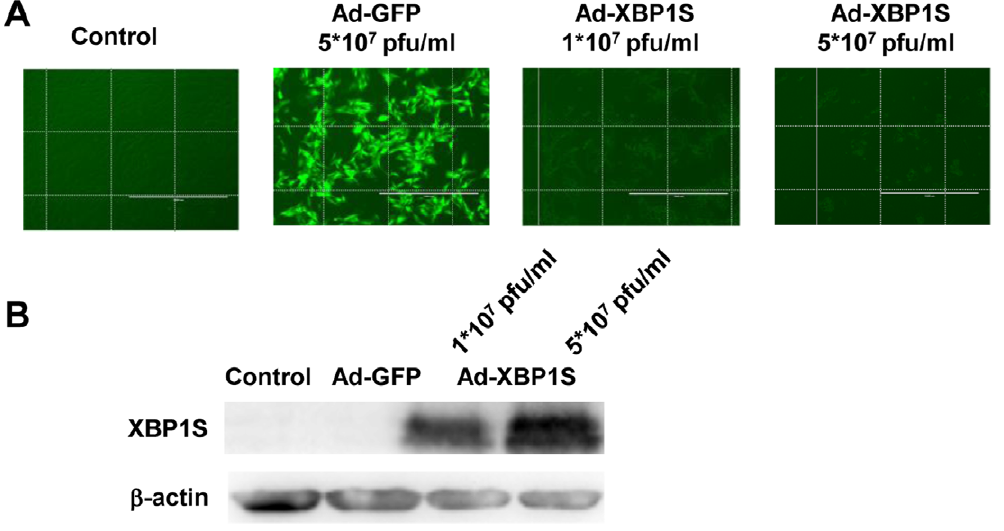
Figure 4. Identification of XBP1S expression after transfection of Ad-GFP or Ad-XBP1S. A: Observation of the cell under fluorescent microscope after transfection of Ad-GFP or Ad-XBP1S for 24 h. B: Western blot analysis on XBP1S protein level after Ad-GFP or Ad-XBP1S transfection for 48 h.